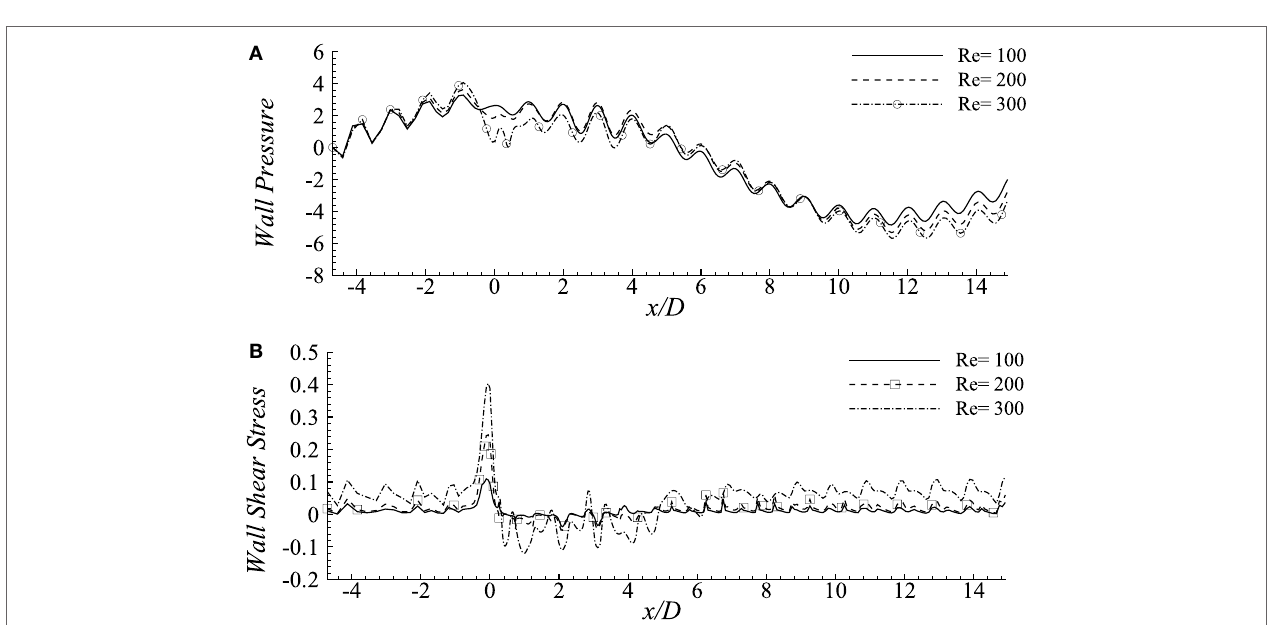
FIGURE 5 | (A) Upper-wall pressure, p / ρ U 2 and (B) upper-wall shear stress, τ w / ρ U 2 for different Reynolds numbers, i.e., Re = 100, 200, and 300 considering the Cross model when stenosis = 60% constricted and aneurysm = 100% dilated where the amplitude of wall oscillation, A = 3 (cid:2) 10 (cid:0) 4 .